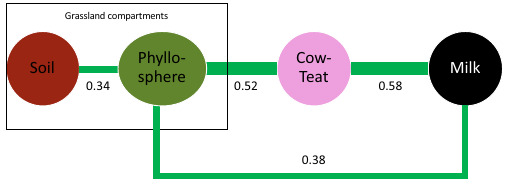
Figure 3. Network analysis of compartment relationships according to their microbial compositions (prokaryotic and fungal). Circles represent compartments and line the significant links derived from the WTO analysis. Line thickness is proportional to link strength as measured by the coefficient of correlation between compartments.